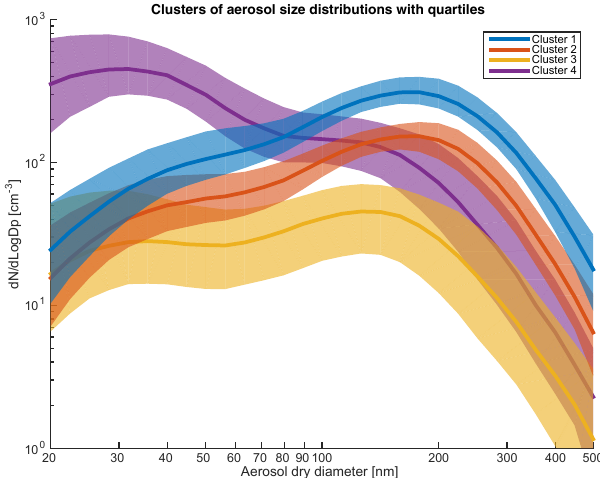
Figure 5. The output of the k -means cluster analysis. The solid curves show the centroids (median) of the number size-distribution of the four clusters. The shaded area denotes the interquartile range of each of the size bins, for all distributions that were members of the given